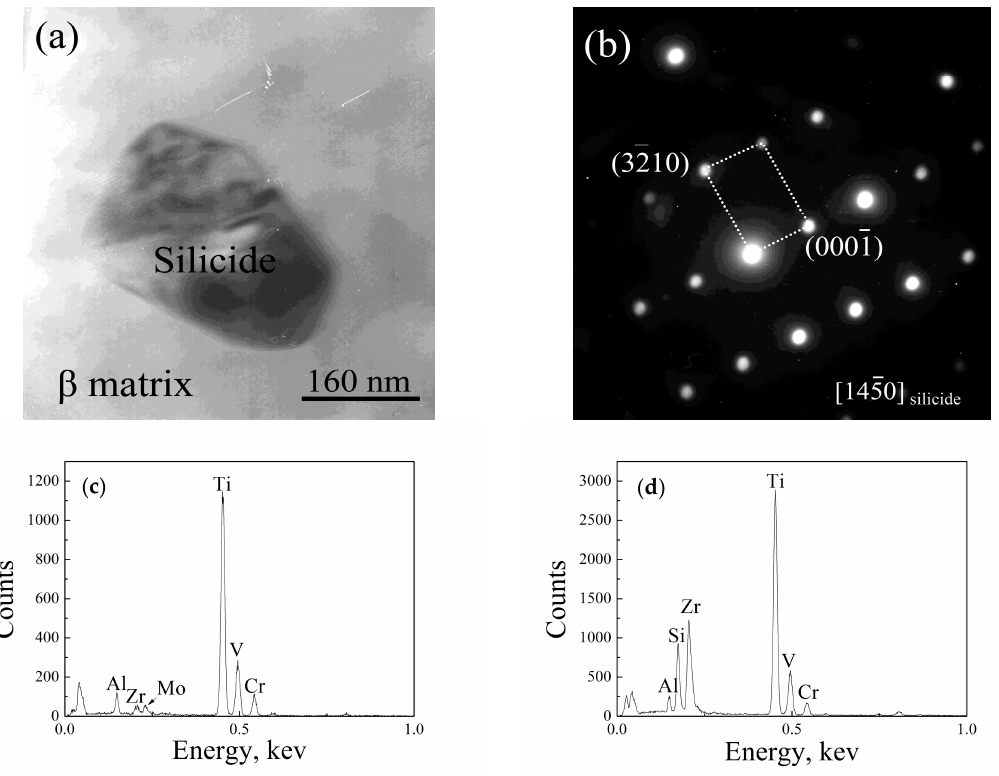
Figure 4. TEM image ( a ); corresponding SAED (Selected Area Electron Diffraction) pattern for the silicide ( b ); EDS (Energy Dispersive Spectroscopy) spectra of β matrix ( c ) and silicide ( d ) for solution-treated alloy C2.